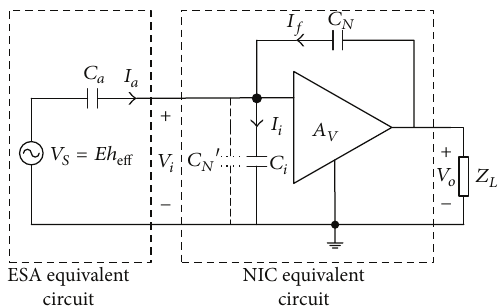
Figure 3: Equivalent circuit of a non-Foster matching electrically small